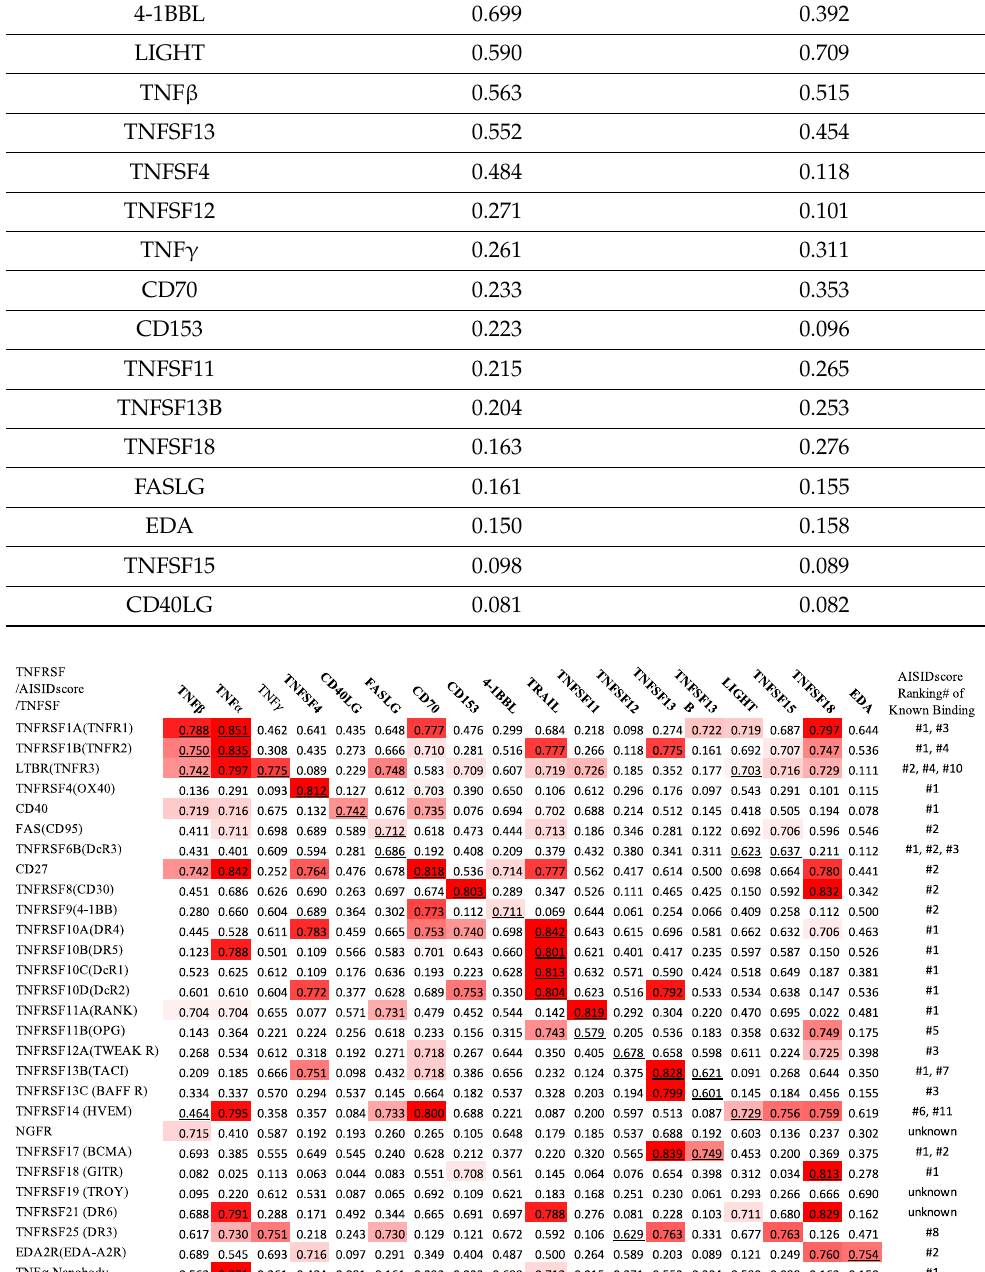
(TRAIL), while their structural information is missing. Surprisingly, the pairing between the DcR1 and DcR2 and their ligand TRAIL gave the highest AISIDscore in the list (Figure 1, Figure 2A,B). Biochemical studies have shown that both DcR1 and DcR2 could specifi- cally bind TRAIL with the K D of ~1nM. DcR1 and DcR2 do not interact with other TNFSF members [18,19]. In another case of CD30/CD30L, both CD30 and its ligand CD30L are with unknown structures. The prediction showed that the CD30/CD30L pair provided the second highest AISIDscore in the list (Figure 2C). The studies using Surface Plasmon Res- onance(SPR) have indicated that CD30 specifically interacted with CD30L with the K D of ~5 nM [20] . Therefore, the prediction results using the AISIDscore are consistent with the previous biochemical studies. The data clearly indicated that the AISIDscore derived from the AlphaFold-Multimer might be a useful indicator to identify the specific interactions.